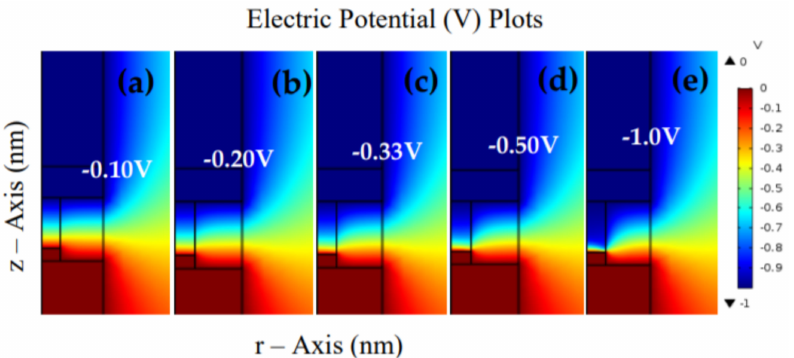
Figure 9. 2D COMSOL images of the RESET process of TiN/Ti/ZnO/Pt device during: ( a ) initial conditions, ( b ) − 0.20 V sweep, ( c ) the reverse voltage at − 0.33 V, ( d ) the voltage sweep at − 0.50 V, and ( e ) the residual CF at − 1.0 V. These images depict the CF rupture during the sweep of the externally applied negative polarity (blue-red portions show the gradual rupture of the CF).